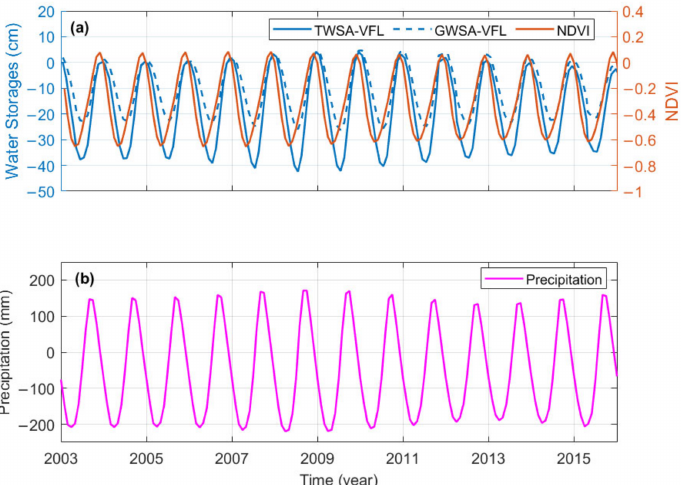
Figure 13. Cumulative monthly seasonal variations of ( a ) water storage from TWSA VFL (blue curve) and GWSA VFL (dashed blue curve), and NDVI (red curve); ( b ) precipitation from 2003 to 2016. The seasonal components were estimated using the STL method.